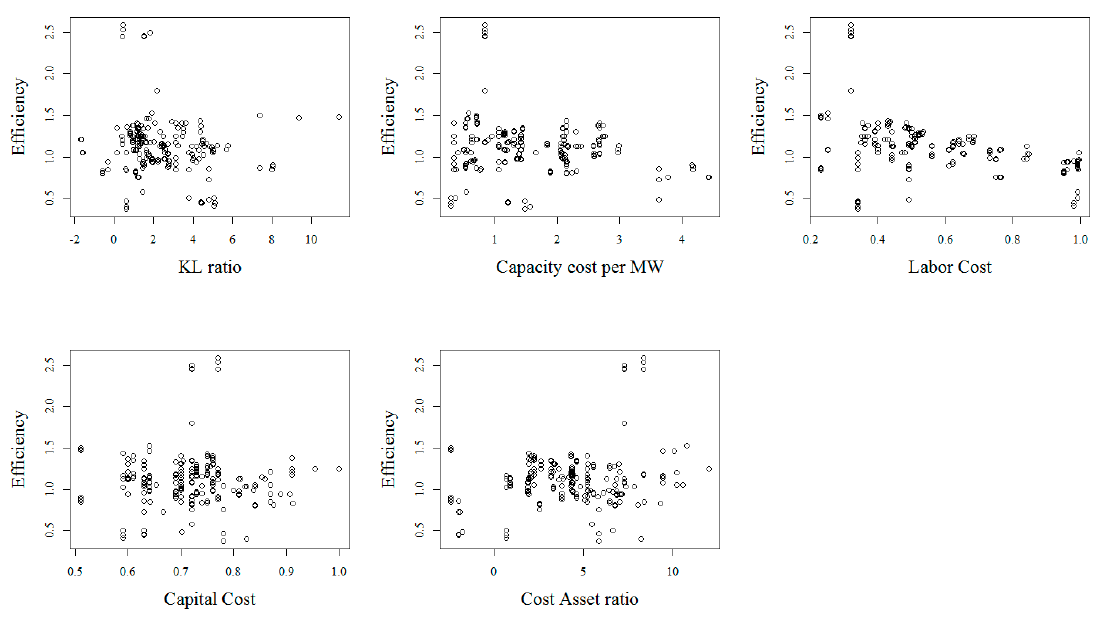
Figure 4. Scatter plots for super-efficiency levels and cost structure variables.